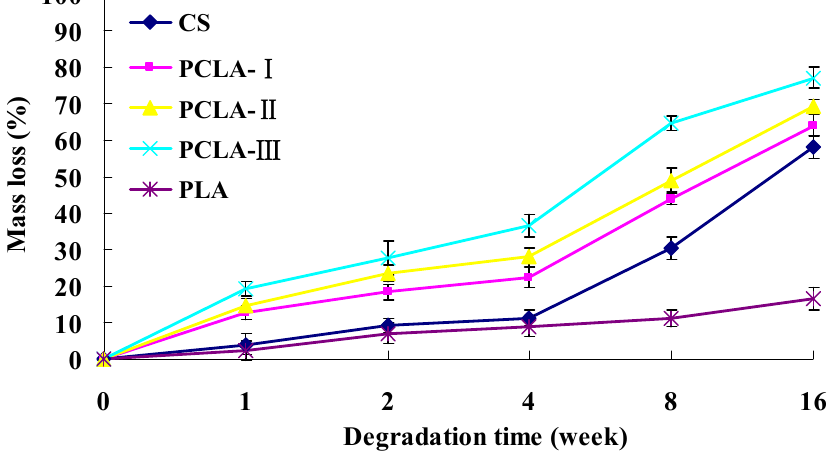
Figure 5. In vivo biodegradation data for CS, PLA and PCLA scaffolds subcutaneously implanted into the backs of Kunming mice for up to 16 weeks (mean ± SD, n =